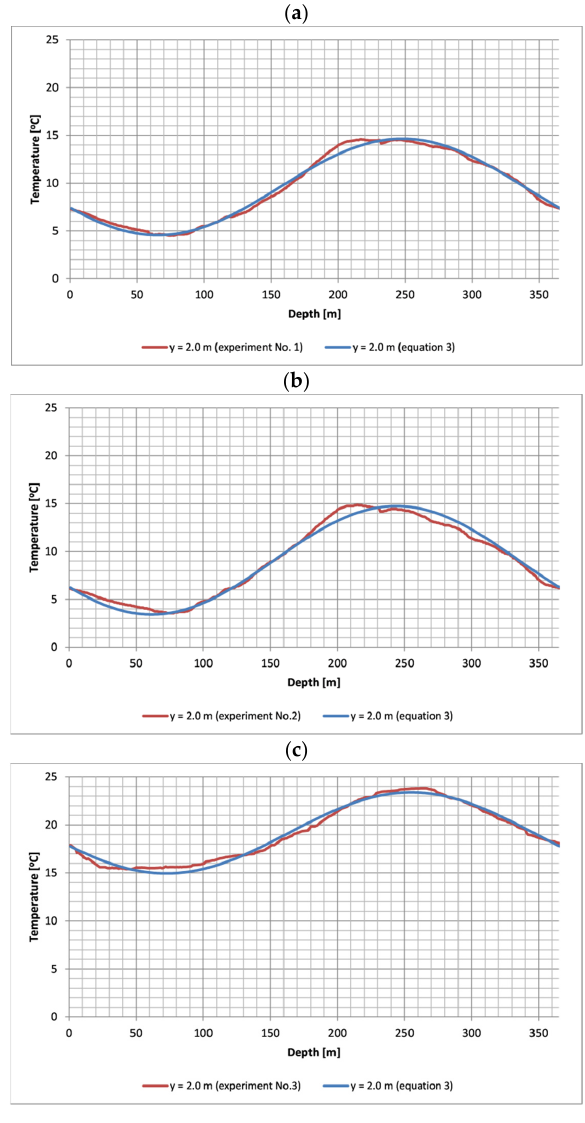
Figure 12. Comparison of the temperature values from the experiments and the computational model at h = 2 m for three measurement points: ( a ) No. 1, ( b ) No. 2, ( c ) No. 3. After substituting the formula (3) to (1), the following form of heat flux density in the ground layer from 0.25 to 3.0 m was obtained: